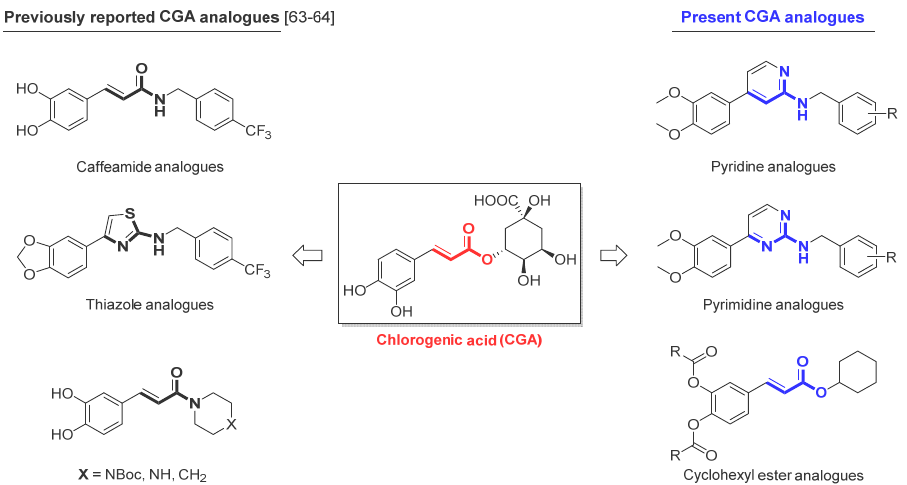
Figure 1. Design strategy for new α‐ MSH ‐ induced melanogenesis inhibitors.